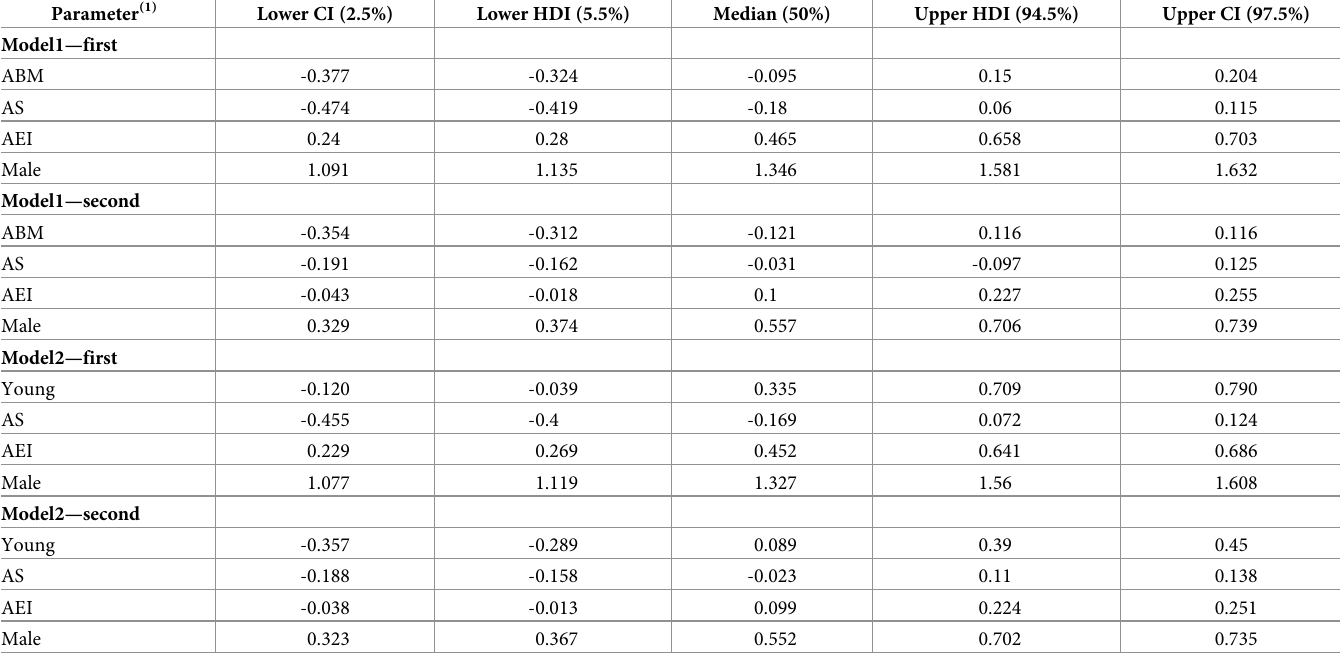
Table 1. Results of